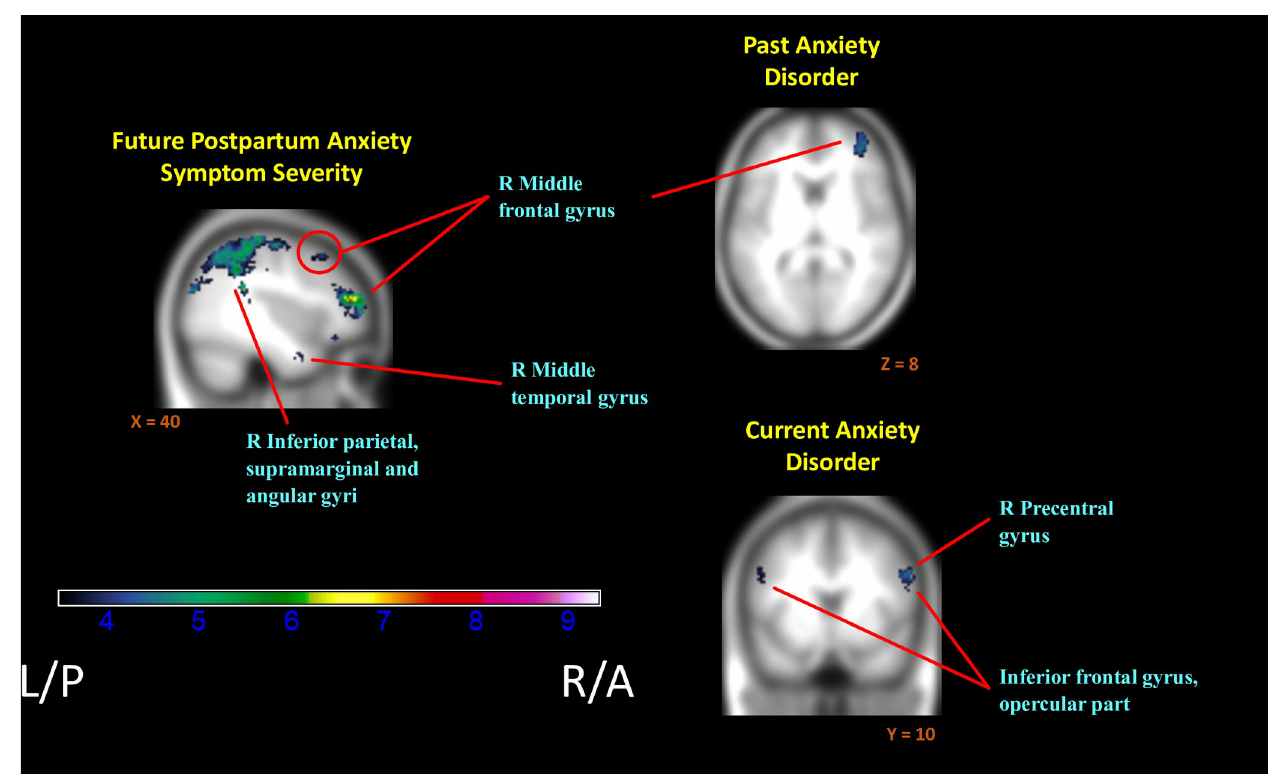
Fig 3. Regions of reduced activation to positive versus negative infant emotion tasks with increasing markers of anxiety. ( i . e . Negative associations of (InfOwnPos > InfOwnNeg) with BAI[T1-T4], Anx-Hx, & Anx-Dx). Anatomical labels added for reference are taken from the AAL atlas , but do not represent an exhaustive list of cluster extent . Activation overlaid on smoothed (8mm Gaussian kernel) average of subject anatomical images .